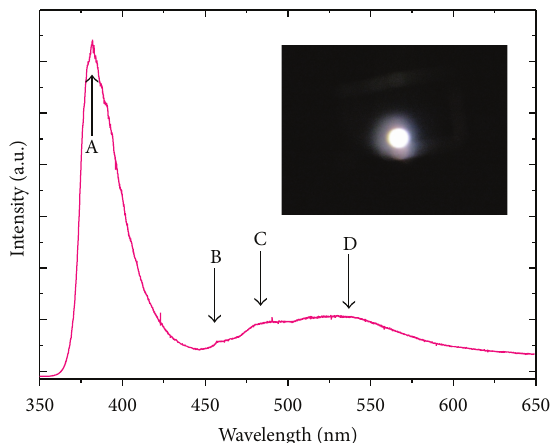
Figure 4: RT PL spectra of ZnO:YAG phosphor (YAG phosphor at 5wt%) on silicon substrate. The inset shows the photoexcited luminescent